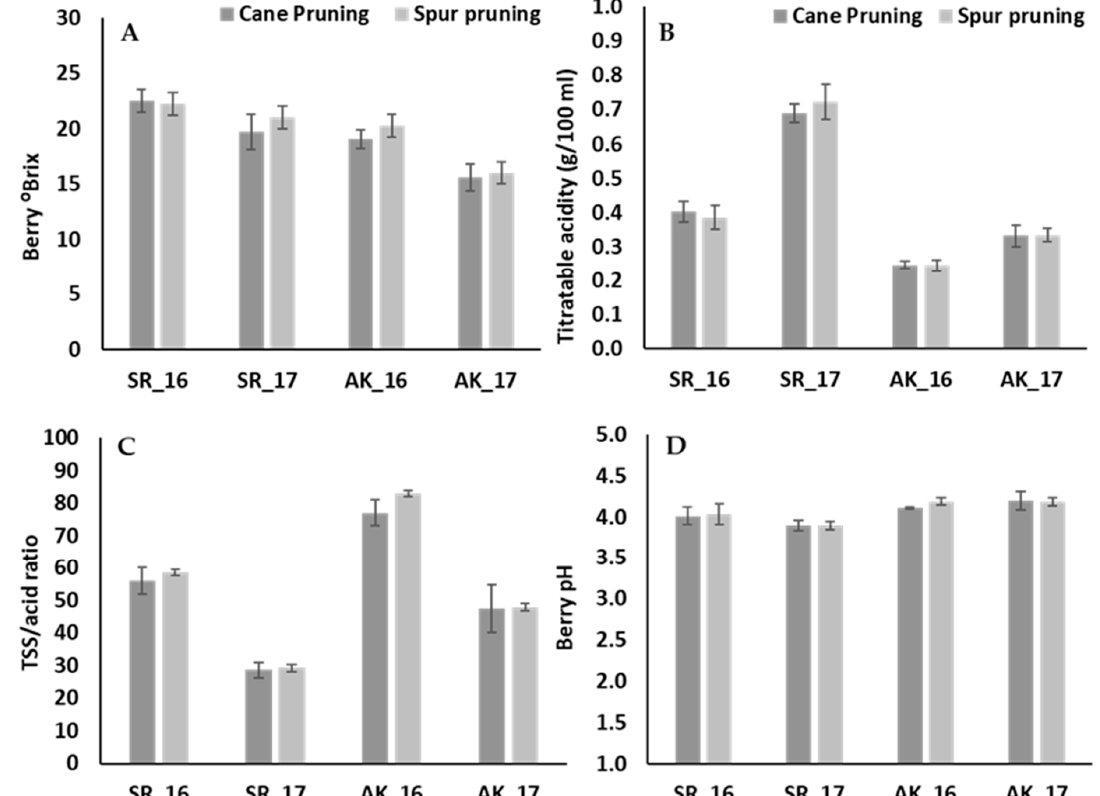
Figure 4. Effect of Head training, cane pruning and Quadrilateral cordon training, spur-pruning systems on berry Brix ( A ), titratable acidity ( B ), TSS/Acid ratio ( C ) and pH ( D ) of Scarlet Royal (SR) and Autumn king (AK) table grapes during 2016 and 2017 seasons. ANOVA statistical analysis was used to measure the differences among treatments at a 0.05 significance level. Error bars represent the standard deviation.